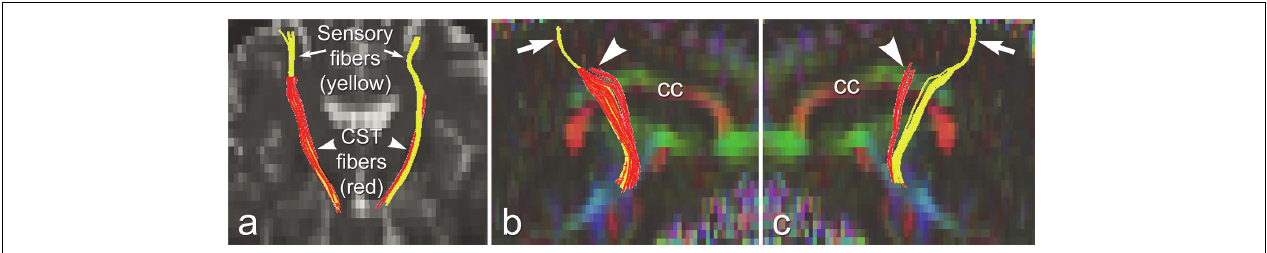
FIGURE 6 | Truncated virtual CST fibers arising from primary motor cortex (red, arrowheads) are contrasted with intact sensory fibers projecting to/from primary sensory cortex (yellow, arrows) in an UMN-predominant ALS patient with faster disease progression rate. Virtual tracts are projected on a coronal b0 image (a) , and on sagittal images of left (b) , and right (c) hemispheres. cc, corpus callosum. Reproduced with permission from Elsevier.